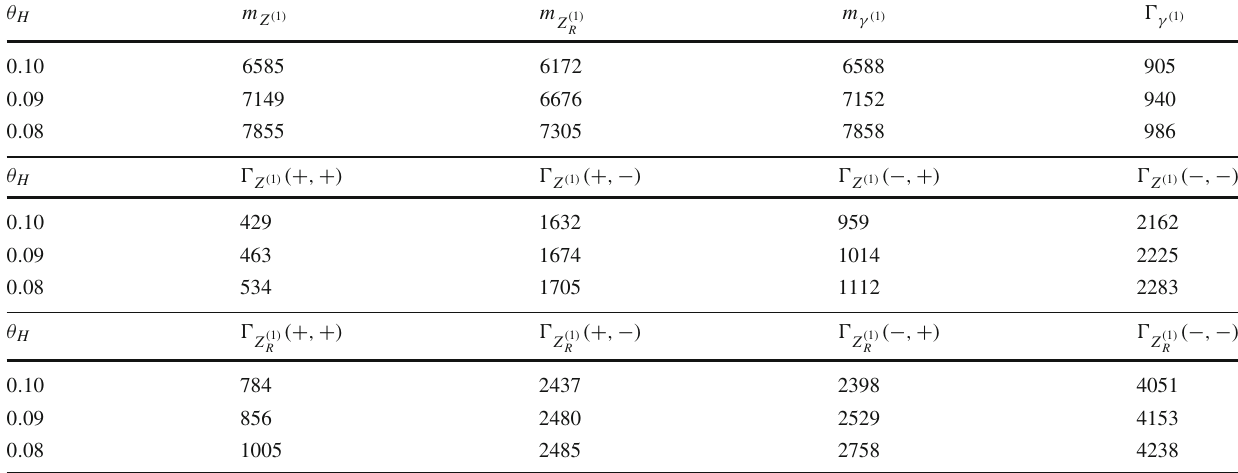
Table 9 Masses of Z ( 1 ) , Z ( 1 ) and γ ( 1 ) and total decay width of γ ( 1 ) in the unit of GeV. (cid:4) γ ( 1 ) is independent of the sign of the bulk R